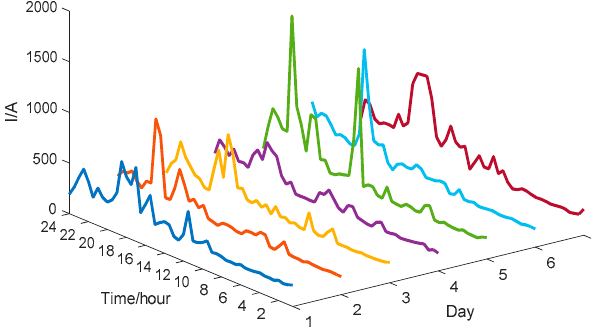
Figure 7. Daily load profiles of a single residential customer for one week.